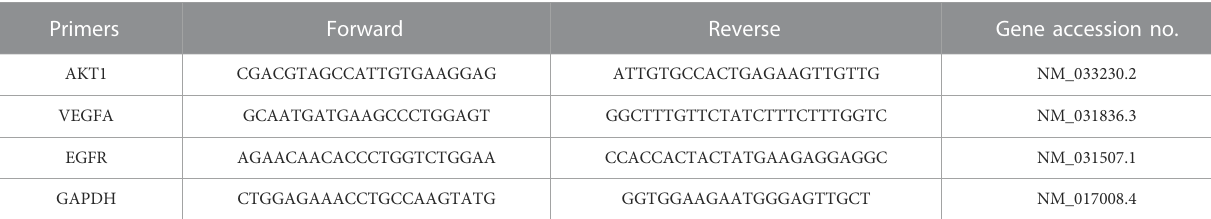
TABLE 1 List of PCR